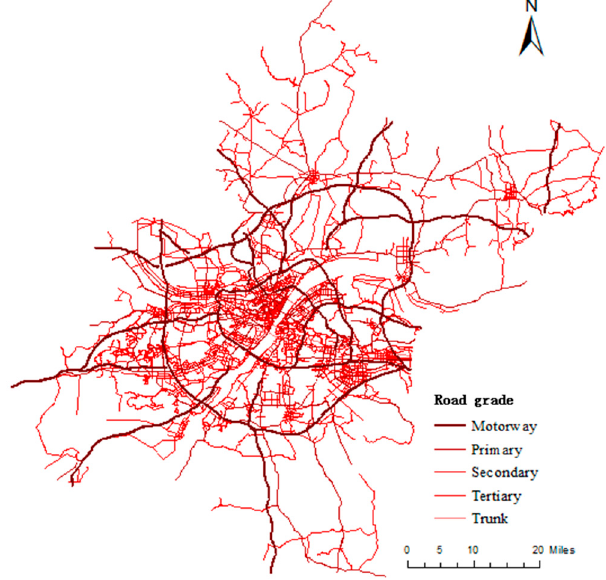
Figure 4. Wuhan road network.